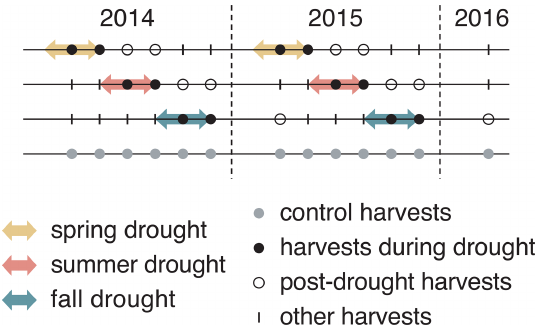
Figure 1. Experimental design of the experiment that lasted for 2 consecutive years (2014 and 2015), with six evenly distributed harvests in both years and one additional harvest at the beginning of 2016. Arrows indicate the duration of each drought treatment (10 weeks). Each treatment was replicated four times for each of six grass species and